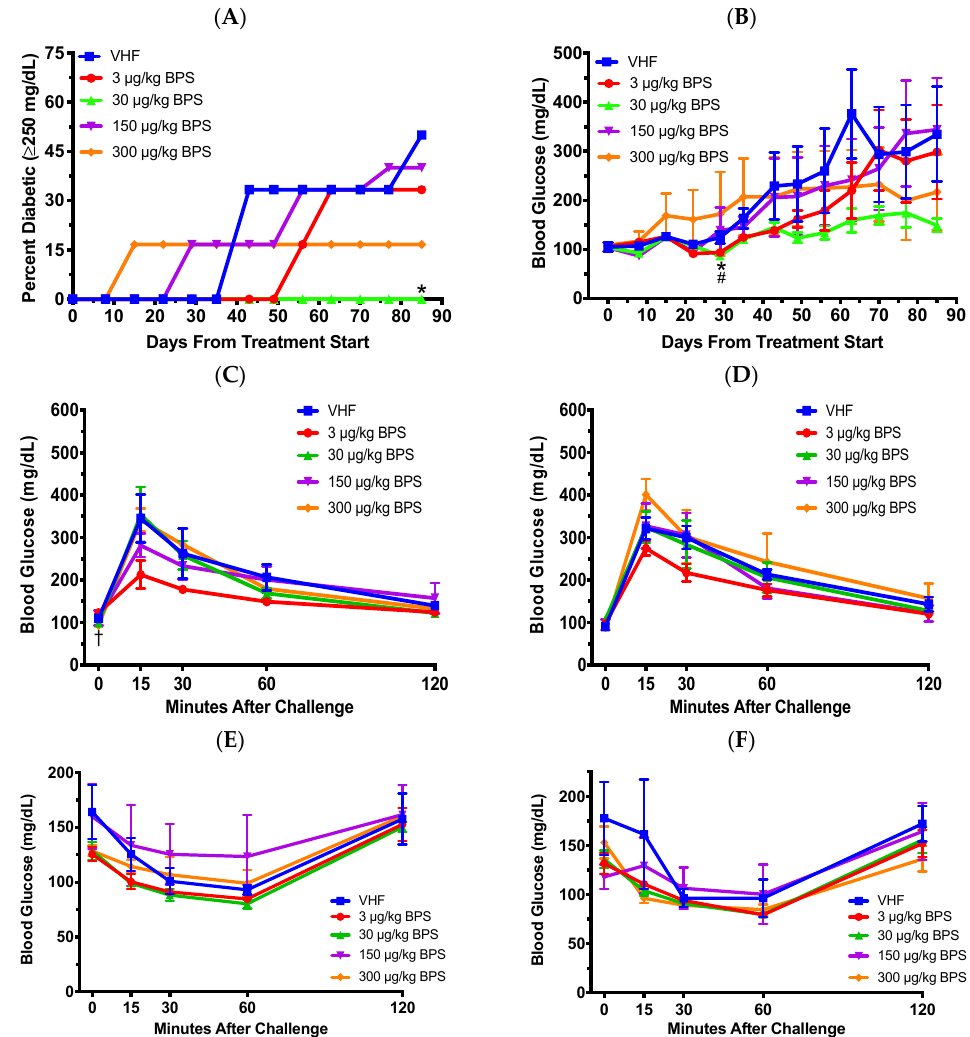
Figure 1. Diabetic incidence, blood glucose levels (BGLs), glucose tolerance tests (GTT) and insulin tolerance tests (ITT) in female non-obese diabetic (NOD) mice on the soy-based diet. ( A ) Type 1 diabetes (T1D) incidence ( N = 5–6). Blood glucose ≥ 250 mg / dL was considered diabetic. ( B ) Time course of non-fasting BGLs. Also shown are GTTs after 1 month ( C ) and 2 months ( D ) of BPS exposure ( N = 5–6), and ITTs after 1 month ( E ; N = 5–6) and 2 month ( F ; N = 3–5) of BPS exposure. The values are presented as mean ± SEM. *, p < 0.05 for 30 µ g / kg BPS vs. vehicle (VHF) control group. # , p < 0.05 for 3 µ g / kg